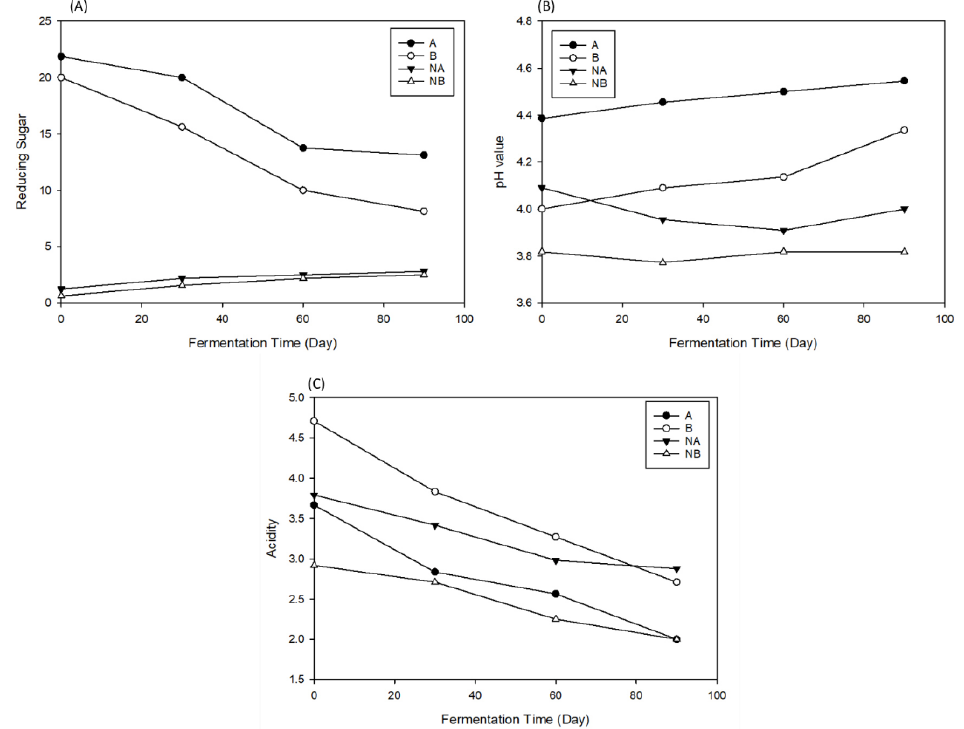
Figure 5. The changes in reducing sugar ( A ), pH value ( B ), and acidity ( C ) during secondary fer- mentation.